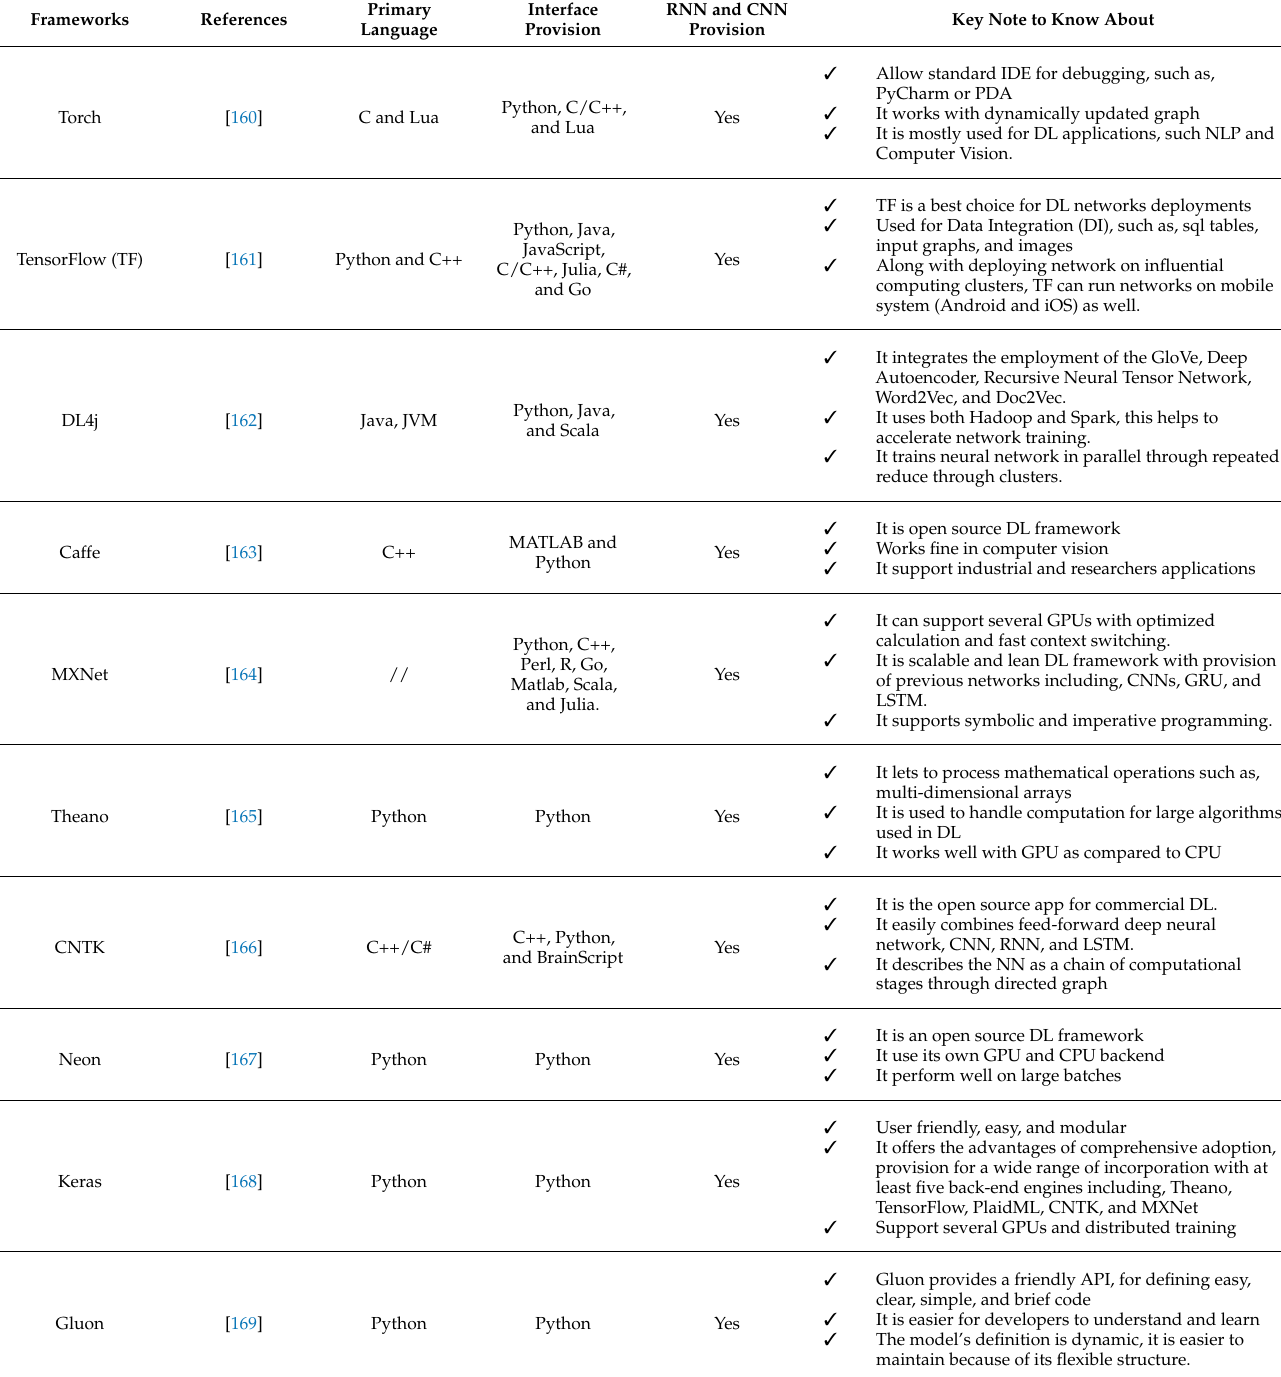
Table 4. Summary of Deep Learning